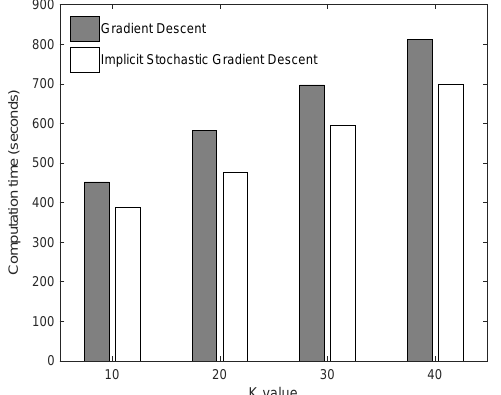
Figure 5. Computation time comparison between two methods.